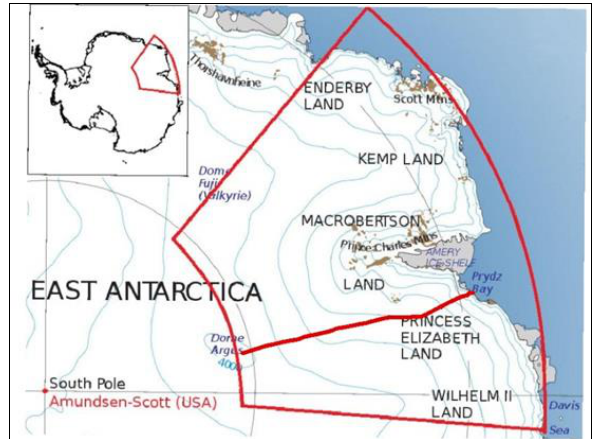
Figure 1. Study area (red boundary) of LAS.